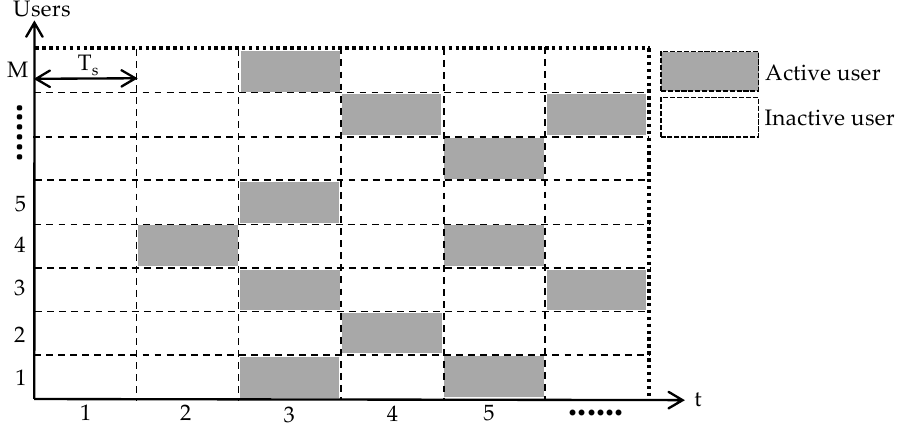
Figure 2. Slot state of the frameless slotted-ALOHA system.